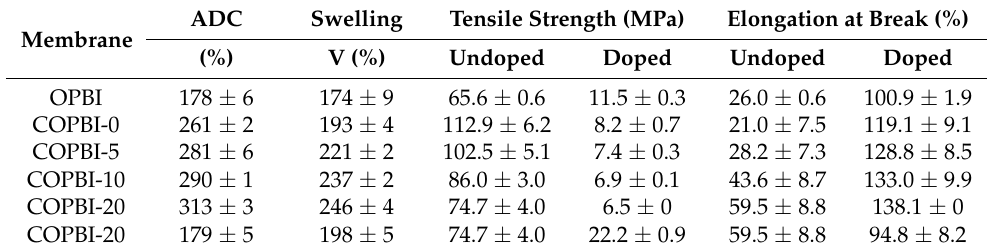
Table 1. Mechanical properties, ADC, and swelling rate of all membranes.